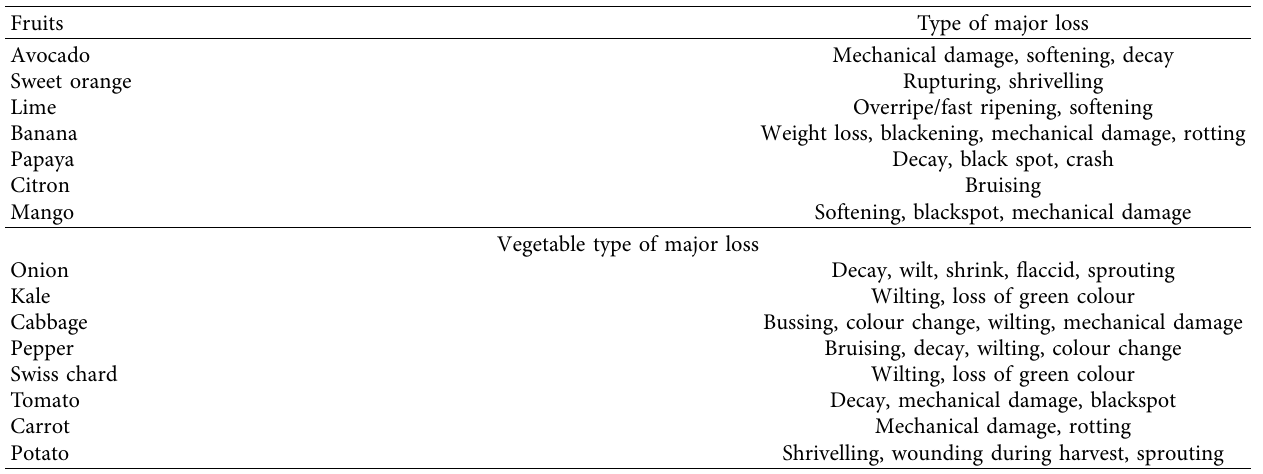
Table 7: Causes of postharvest